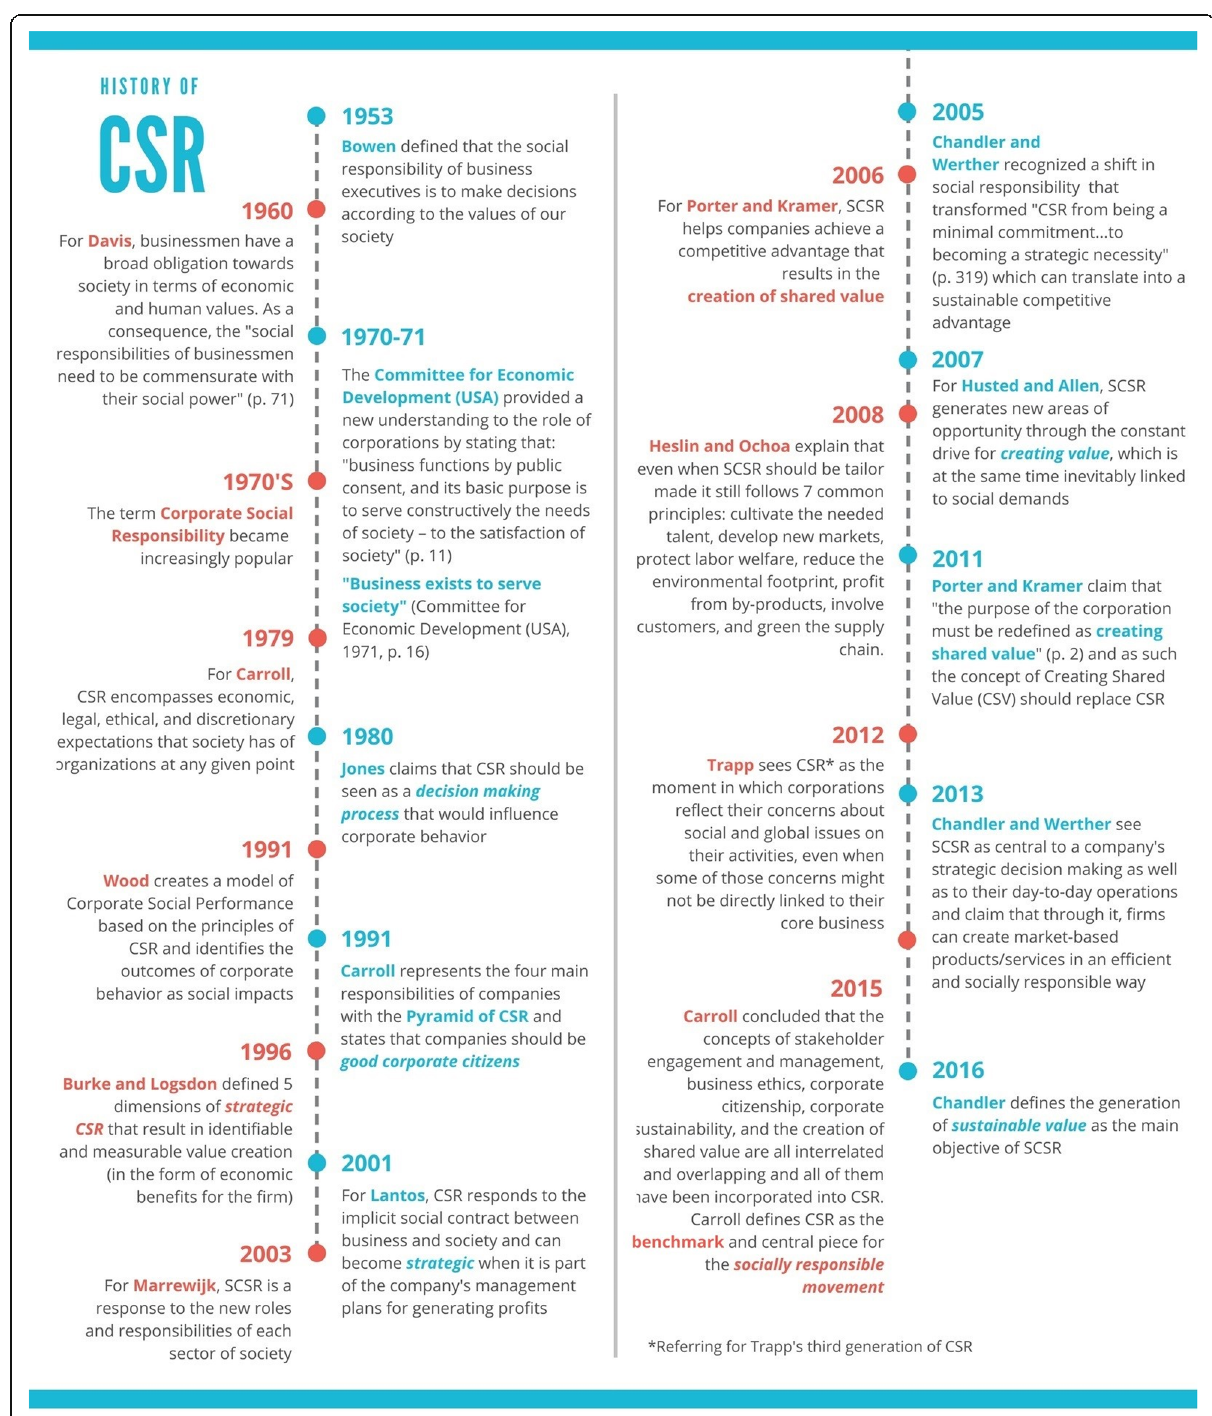
Fig. 1 Evolution of the academic understanding of CSR. Source: Developed by the authors as a synthesis of the academic